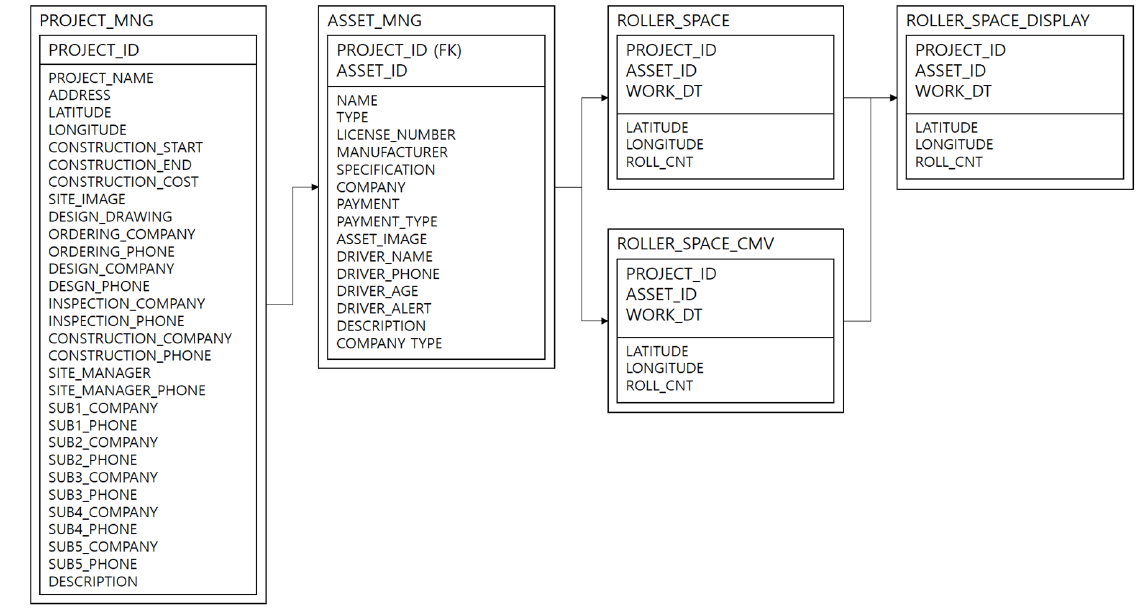
Figure 4. Entity ‐ relation diagram of a system for compaction information. Figure 4. Entity-relation diagram of a system for compaction information.